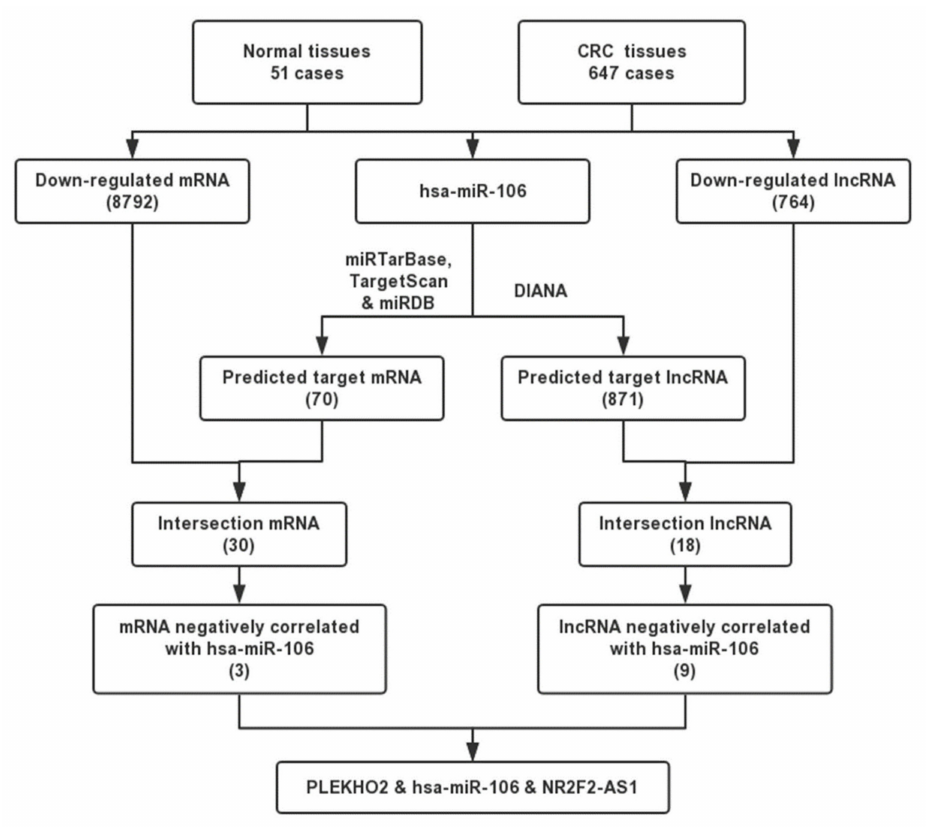
Figure 3. Flow chart of predicting mRNAs and lncRNAs target of